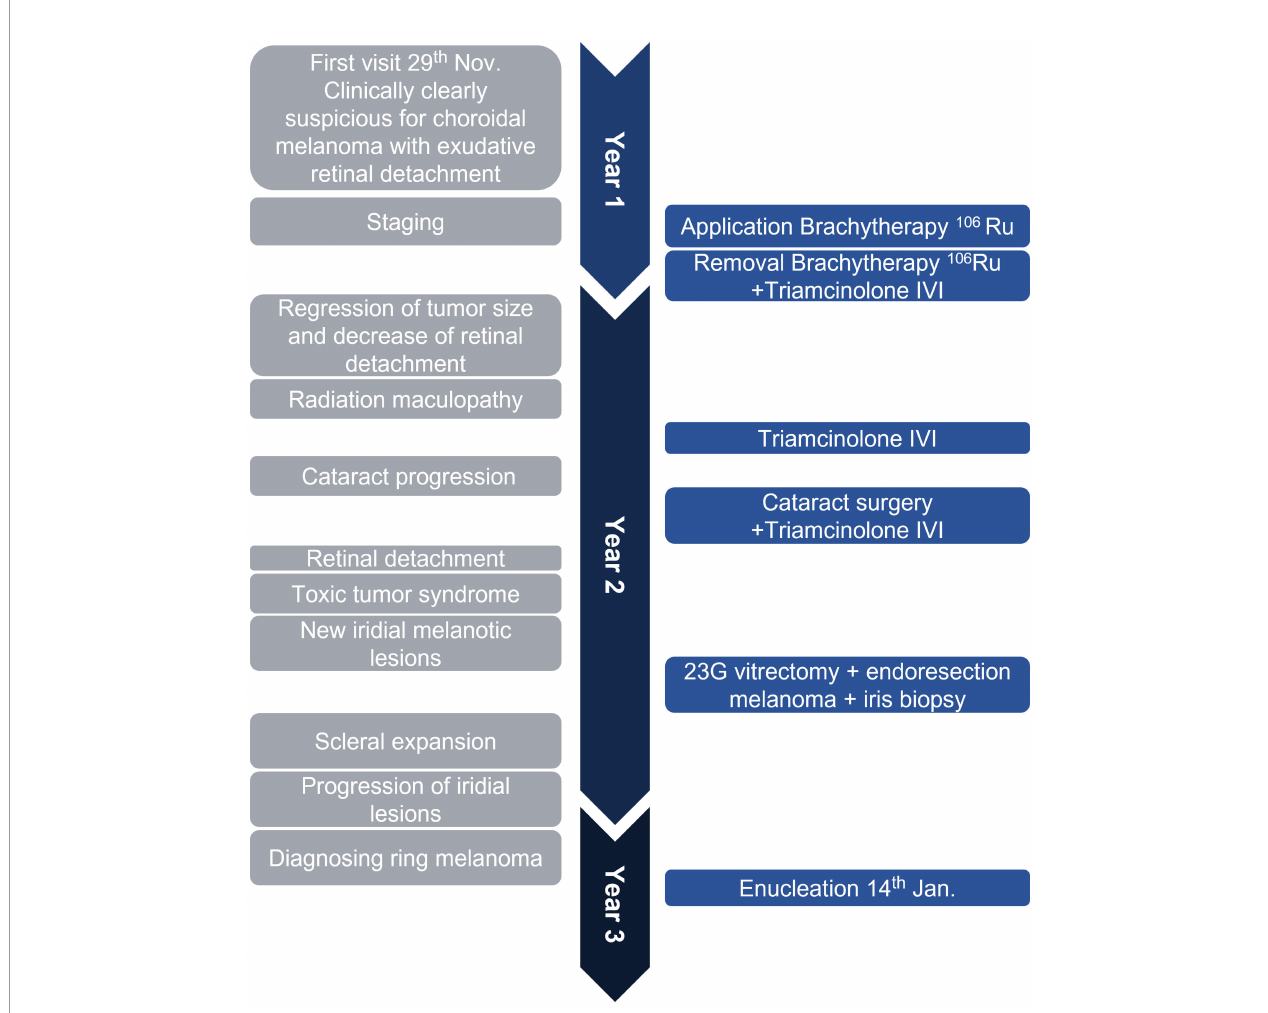
FIGURE 4 | Thetimelineillustratestherapiddisease course inthiscase.Inabout1year and2months,thepatientreceivedtheprimarydiagnosis ofuvealmelanoma,underwent brachytherapywithgoodtumorregression, was treatedfor radiationretinopathy,thendiagnosedwitharing-shapedrelapse,andunderwentenucleationoftheeye.Theleftgray sidelistsimportantclinicalfeatures,andthe rightbluesidedemonstratessurgicalinterventions. IVI, intravitrealinjection; Ru 106 , ruthenium-106;23G,